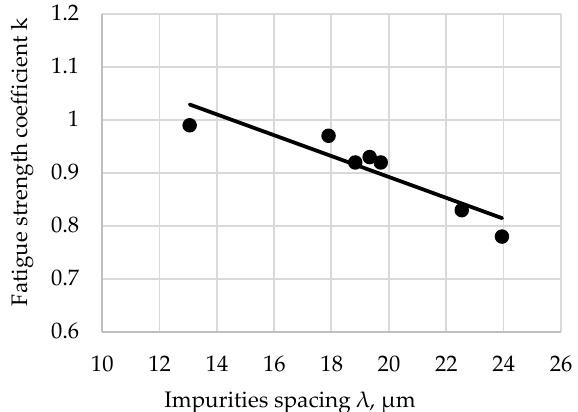
Figure 7. Fatigue strength coefficient, k , of the tested steel after hardening from 880 ◦ C and tempering at 500 ◦ C depends on impurities spacing λ